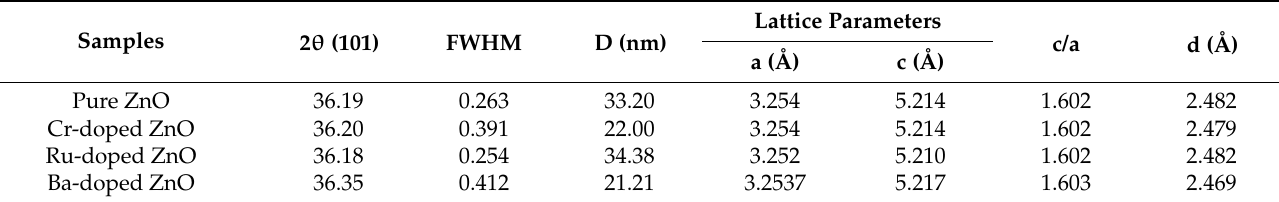
Table 1. Structural properties of the fabricated nanomaterials.